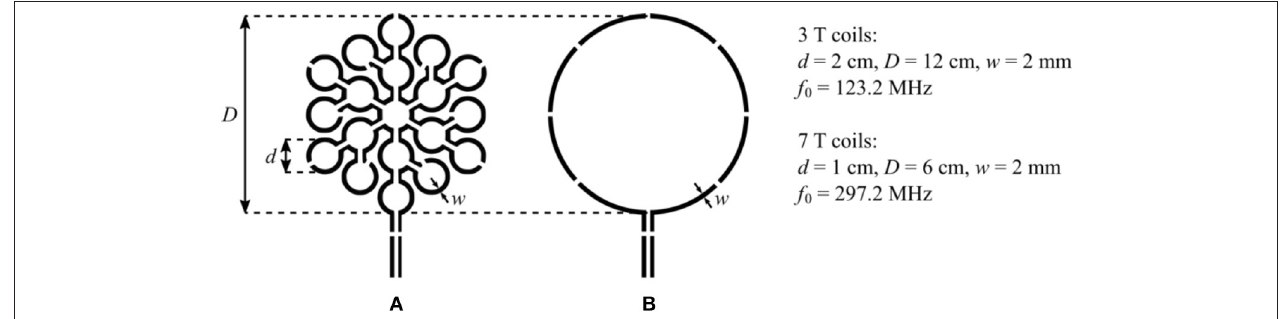
FIGURE 1 | (A) General scheme of the investigated MLCs. Each MLC is composed of 19 loops of diameter d connected in series covering an equivalent circular surface of diameter D . (B) Scheme of the SLCs having a diameter D used for comparison. For all coils, the gaps in the coil winding are made for placing the distributed tuning capacitor, and the gaps on the two straight lines at the bottom of the coils’ winding are made for placing the balanced matching capacitors.